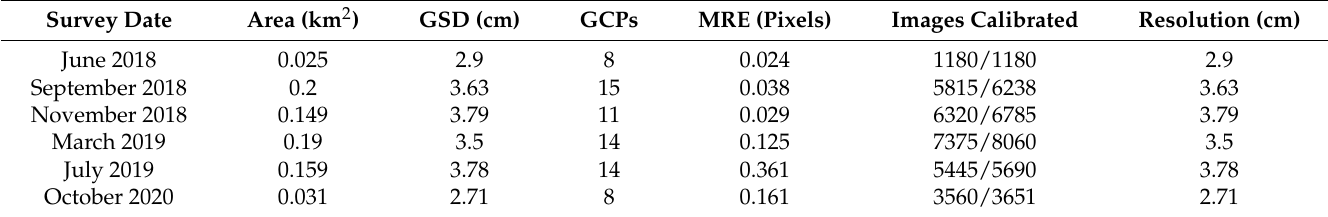
Table 3. Pix4D structure from motion processing details and results for the orthorectified reflectance